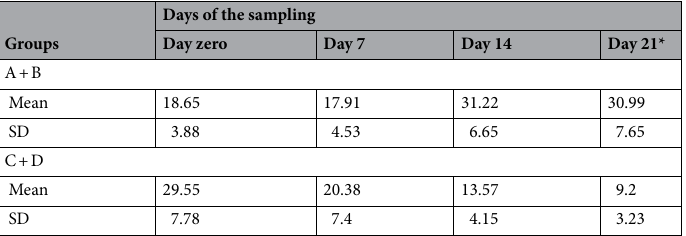
Table 2. The Mean ± SD of 25D 3 in groups A + B and C + D before Cholecalciferol injection. The 25D3 in Group A + B increased by 12.34 ng/mL and decreased by 20.35 in groups C + D. The time factor had a significant effect on 25D3 variations in both groups ( P < 0.01). The interaction between time and group was significant ( P < 0.001).